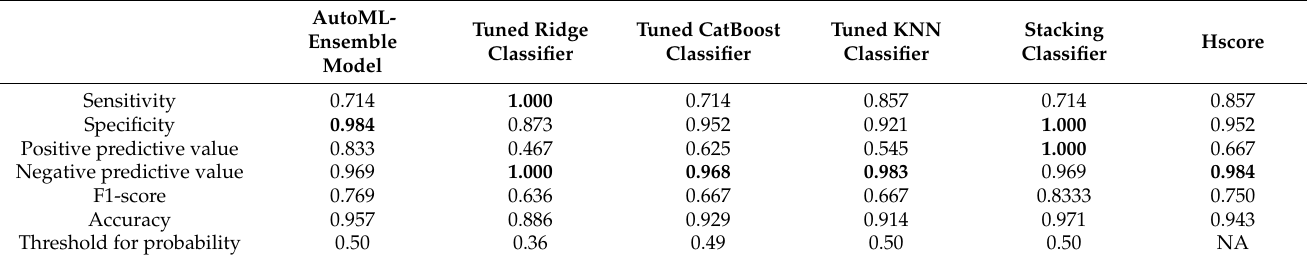
Table 3. Performance metrics on the test data for the five different algorithms used for HLH detection. The highest metric value for each model is displayed in bold type.